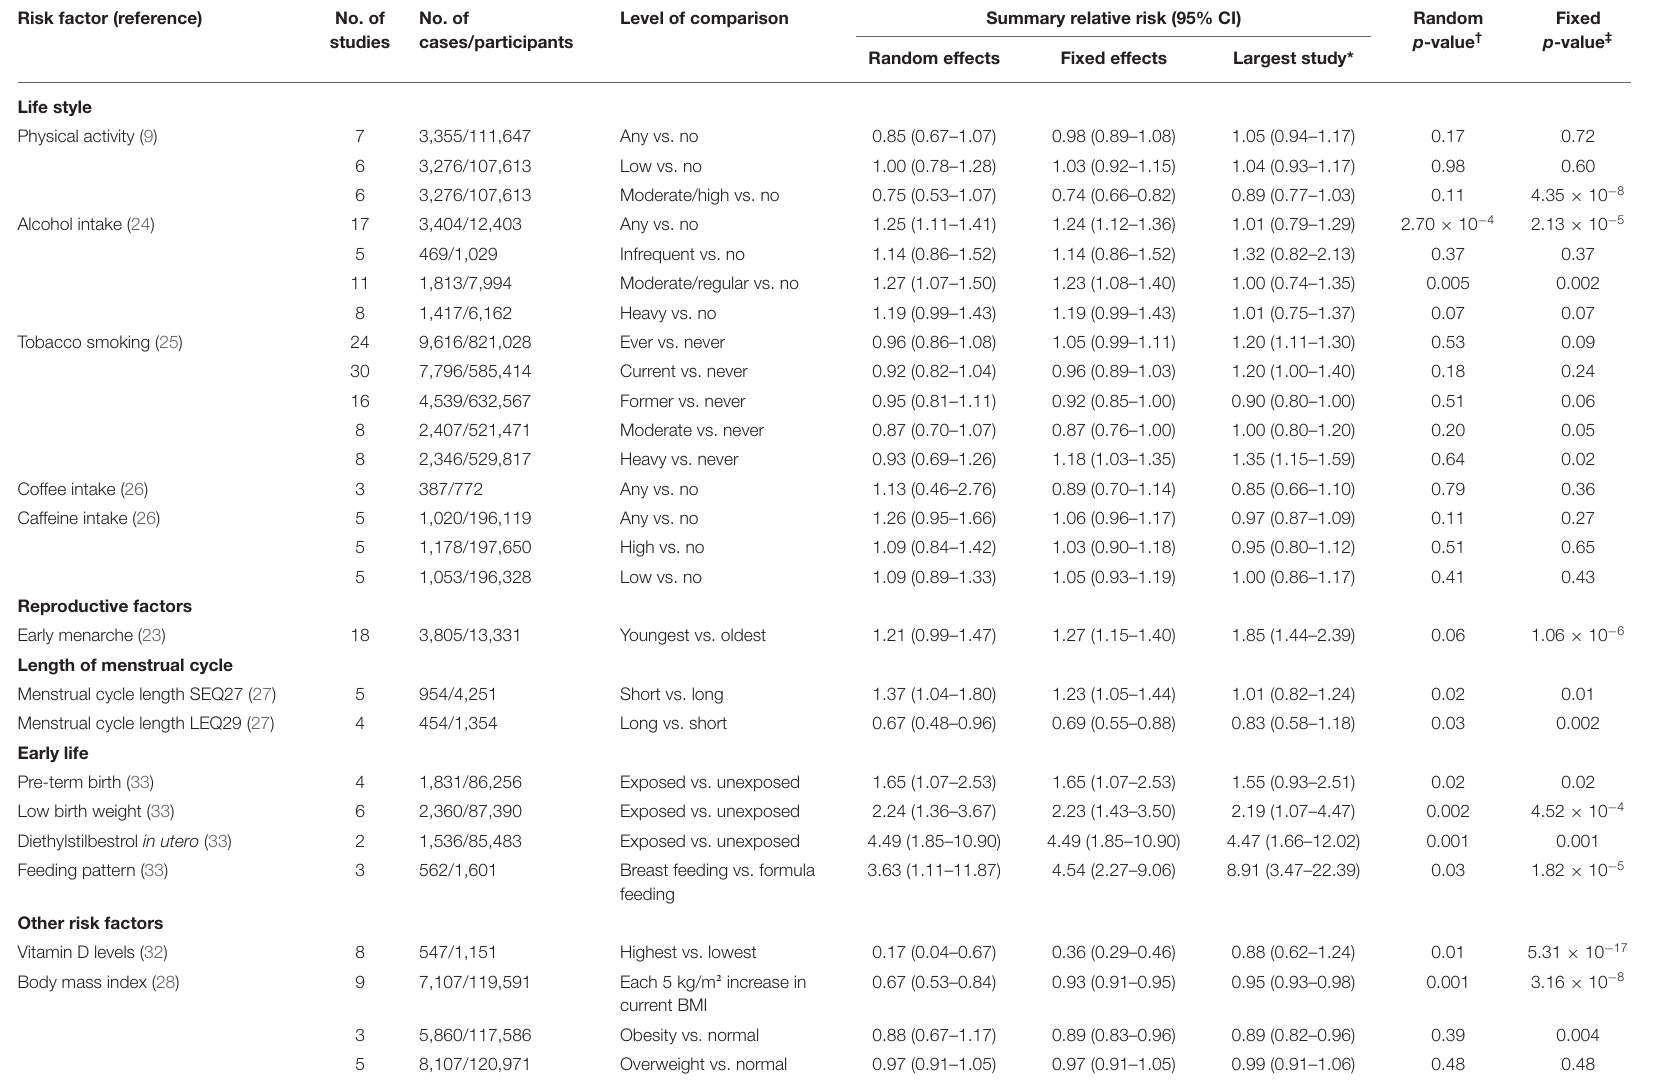
TABLE 1 | Characteristics and quantitative synthesis of the eligible meta-analyses of multiple risk factors for